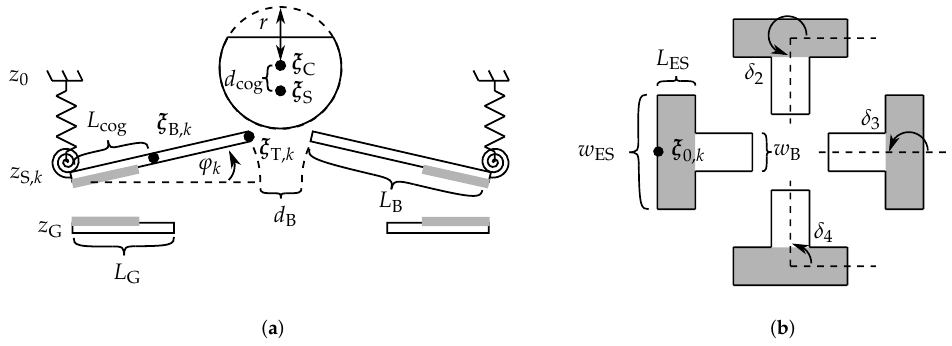
Figure 2. System parameters used for the derivation of the motion equations. ( a ) Side view of the actuator illustrating the sphere, movable beam, and ground plates parameters. The gray parts correspond to the electrical contacts. ( b ) Top view of the electrostatic beams without sphere. The beams are symmetrically arranged and the respective rotations around the z -axis are described by parameters δ k , k = 1, . . . ,4. The parts shaded in gray illustrate the dimensions of the parallel plate actuators’ electrical